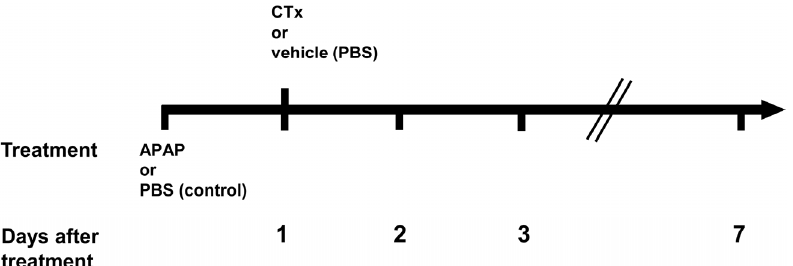
Figure 7. Schematic overview of the experimental design. Animals were injected acetaminophen (APAP) or phosphate-buffered saline (PBS) as control. One day after treatment, partial hepatectomy (PH) followed by cell transplantation (CTx) (or PBS injection as vehicle control) was performed. Samples for biochemical and histological analyses were taken 1, 2, 3, and 7 days after treatment. At day 1, samples were taken just prior to PH and CTx.